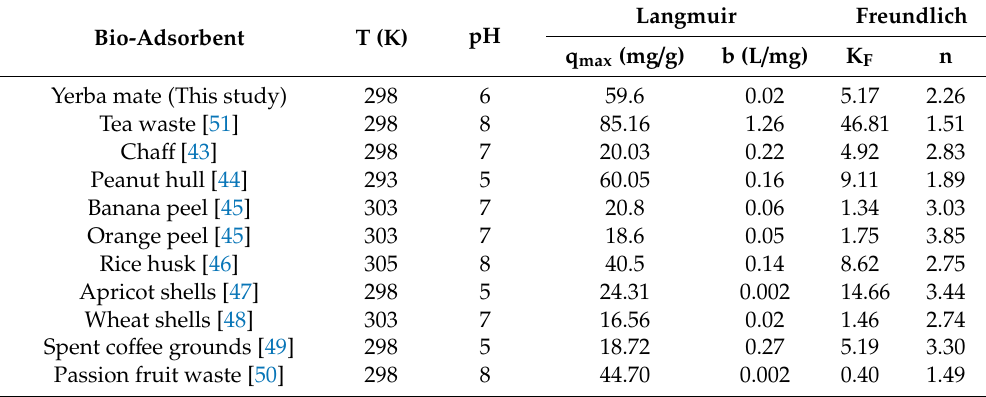
Table 3. Comparison of the Langmuir and Freundlich constants for different types of food waste bio- adsorbents.